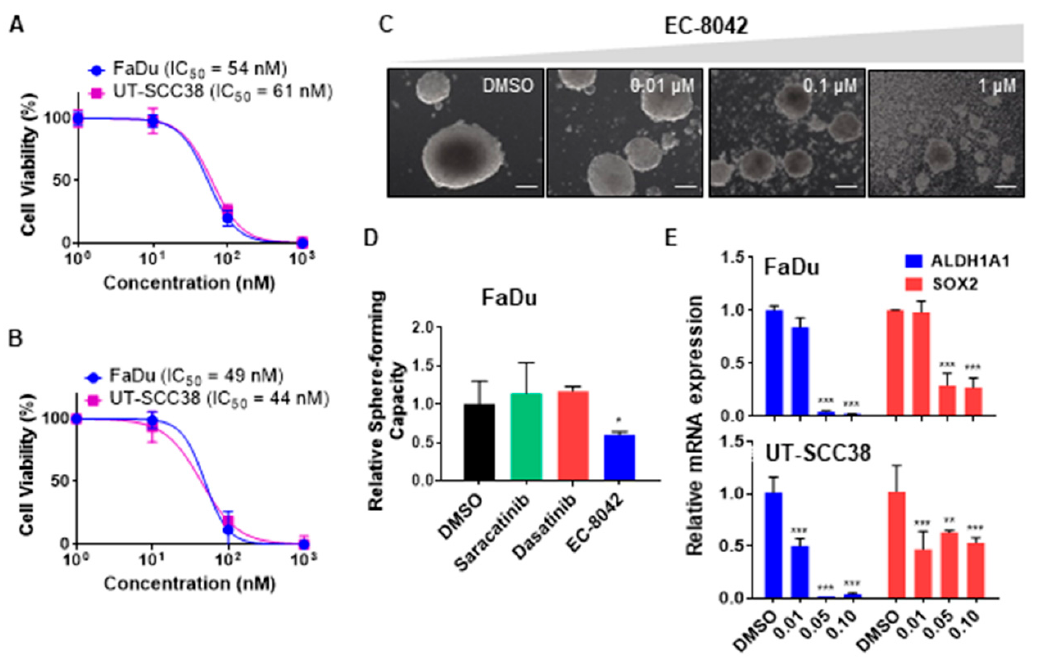
Figure 3. Effect of the mithralog EC-8042 on the viability and CSC properties of HNSCC-derived cell lines. ( A , B ) Dose-response curves of the cell viability by MTS in UT-SCC38 and FaDu adherent cells ( A ) or CSC-enriched tumorspheres ( B ) treated with increasing concentrations of EC-8042 for 72 h. IC 50 values are shown. ( C ) Representative images of FaDu tumorspheres upon treatment for 72 h with different doses of EC-8042. ( D ) Tumorsphere-forming ability of FaDu cells upon treatment for 72 h with either DMSO (vehicle), 0.1 μ M dasatinib, 1 μ M saracatinib, or 0.1 μ M EC-8042. ( E ) RT-qPCR analysis of the CSC-markers ALDH1A1 and SOX2 in adherent cultures of FaDu and UTSCC38 cells treated with increasing concentrations of EC-8042 for 72 h. Data are expressed relative to DMSO- treated cells (mean ± SD, Student’s t -test, * p < 0.05, ** p < 0.01, *** p < 0.001).